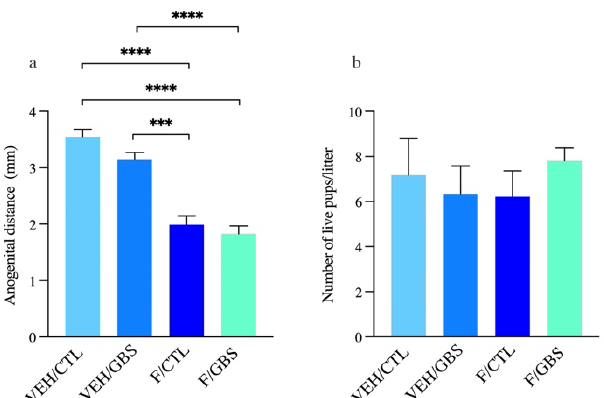
Figure 1. Flutamide acts as an antiandrogen by reducing AGD in pups. ( a ) The AGD of pups exposed in utero (G18–21) to flutamide or vehicle. ( b ) Number of live pups/litter. Analyses were done by one-way ANOVA with Tukey’s multiple comparison. Bars represent mean ± SEM. Number ( n ) of pups in vehicle/control: n = 6, vehicle/GBS: n = 5, flutamide/control: n = 5, flutamide/GBS: n = 5. One male was used per litter for analysis. *** p < 0.001, **** p <